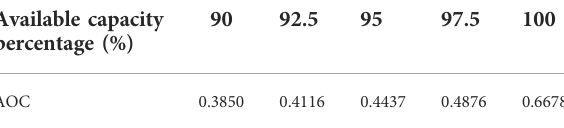
TABLE 7 AOC of wind power corresponding to key AOC (600 MW). Available capacity percentage (%)